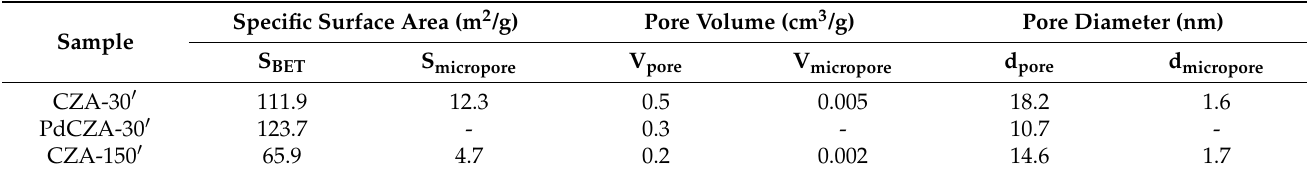
Table 2. Specific surface area, pore volume, and diameter calculated after BET analysis. Sample